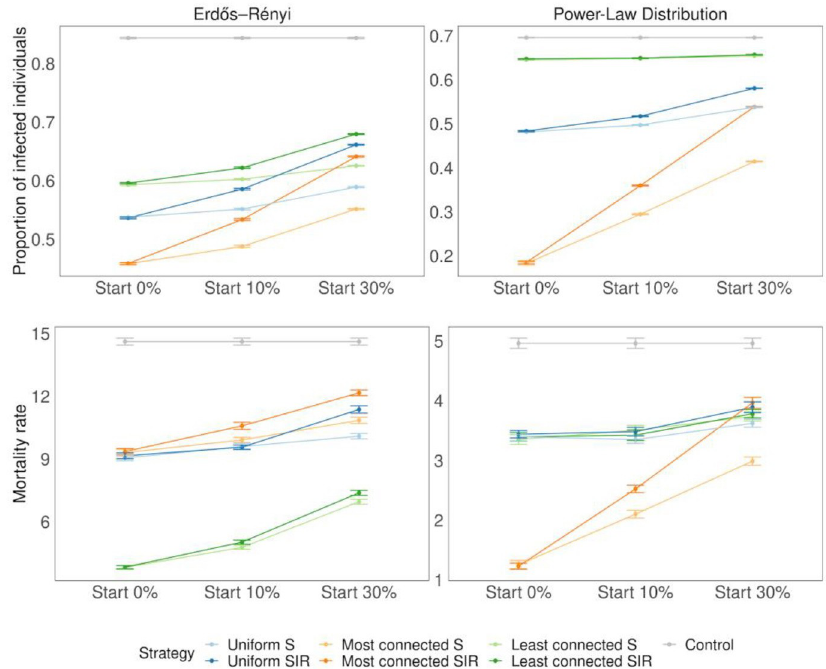
Fig 3. Proportion of infected and dead individuals for three vaccination strategies. The plot shows the proportion of infected at the end of the infection for 30 repetitions. The number of doses of the vaccine represents 25% of the population size (N = 20000). Error bars represent standard deviation. Different starting times are shown in the different panels (when 0, 10 and 30% of the individuals have been infected). On the top right panel, when vaccinating the most connected, the epidemic always died out quickly, before infecting at least 50 individuals, which is the minimum required to be considered a successful simulation (see Methods).